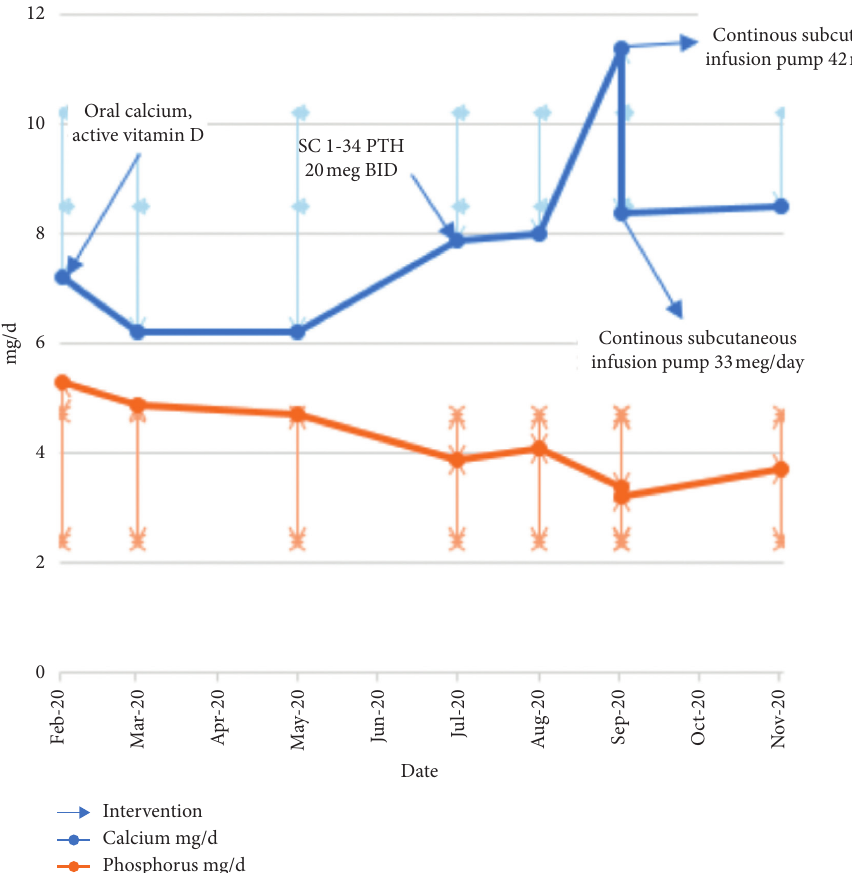
Figure 1: Review of her phosphorus and calcium levels prior to oral calcium and vitamin D replacement, to subcutaneous 1-34 PTH therapy, and to CSPI